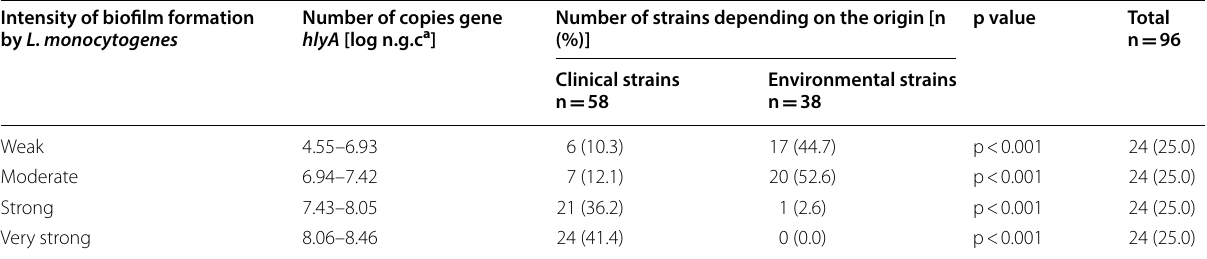
Table 6 Classification of tested L. monocytogenes rods depending on the strength of biofilm formation on the steel surface based on the number of copies of the hlyA gene assessed by droplet digital